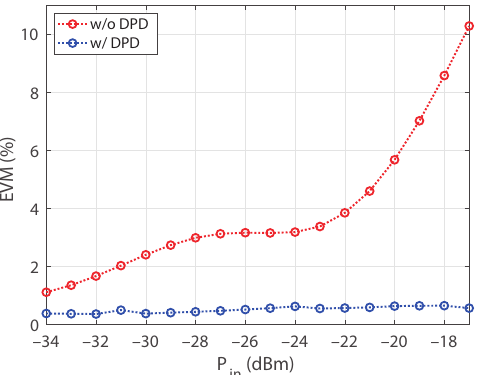
Figure 10. EVM versus the input power level at the VSG, without and with the DPD, with a model structure identified at P o = 27.6 dBm and then reused for all the power